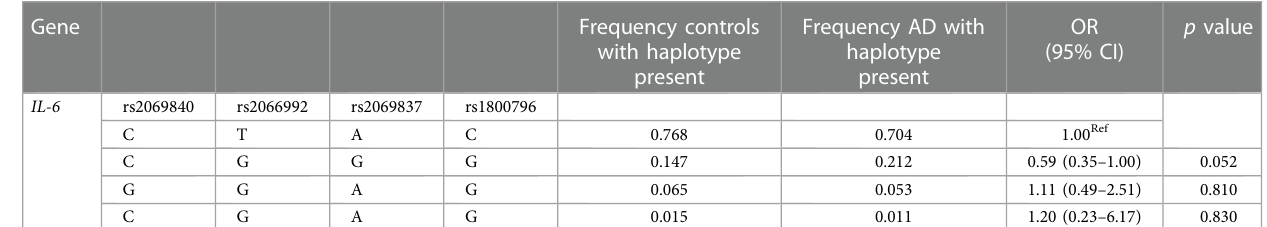
TABLE 6 Haplotype frequencies of IL-6 in AD patients and control. Gene Frequency controls